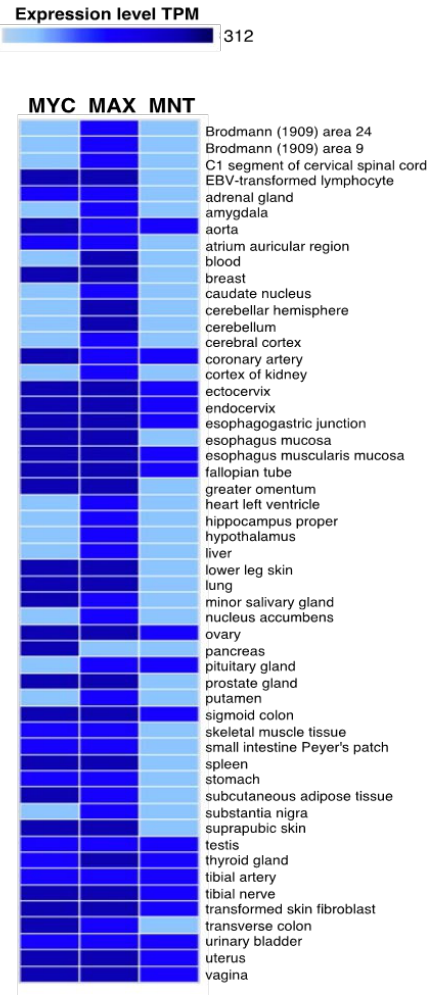
Figure 2. Expression of MYC , MAX , and MNT in human tissues. Data obtained using the GTEX Portal (gtexportal.org). TPM, transcripts per million. During Xenopus laevis development, the MNT orthologue XMnt is expressed in early embryos at the neurula stage and in migrating cranial neural crest cells [33]. The expres- sion of Mnt in the neural tissues of mice and Xenopus seems consistent with the cleft pal- ates and craniofacial deformities observed in Mnt -deficient mice [11,34]. In Xenopus , XMnt , XMad1, and XMad3 exhibit distinct areas of expression during embryogenesis, sug- gesting non-redundant functions [33]. Both quiescent cells and fibroblasts express MNT throughout the cell cycle . MNT lev- els do not increase upon serum stimulation of quiescent cells [30]. This is in contrast with the expression pattern of MYC (expressed mainly in proliferating cells) and most other MXD proteins, such as MXD1 , MXI1 , and MXD4 (mainly expressed in quiescent cells). Thus, MNT–MAX dimers coexist with MYC–MAX in proliferating cells [1]. MNT re- presses its own expression in a MAX-dependent manner by direct binding to its promoter. E-box 2, which is mapped at − 788 bp from the transcription start site, is critical for this autoregulation. A decrease or absence of MAX results in high levels of MNT, which are